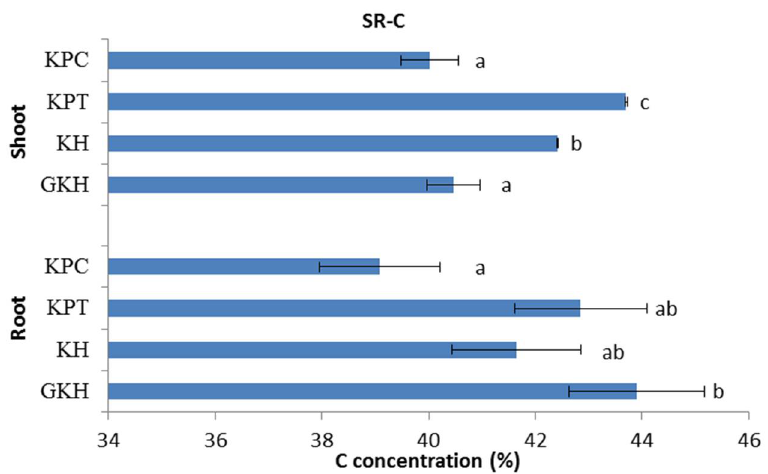
Figure 4. Carbon (C) concentration in the plant community aboveground (Shoot) and belowground (Root) at different grazing intensities: GKH (3.75 ± 0.75 sheep/ha), KH (7.25 ± 0.25 270 sheep/ha), KPT (8.50 ± 0.35 sheep/ha), and KPC (11.75 ± 0.95 sheep/ha). Notations: different letters indicate significant differences between pastures ( α = 0.05).